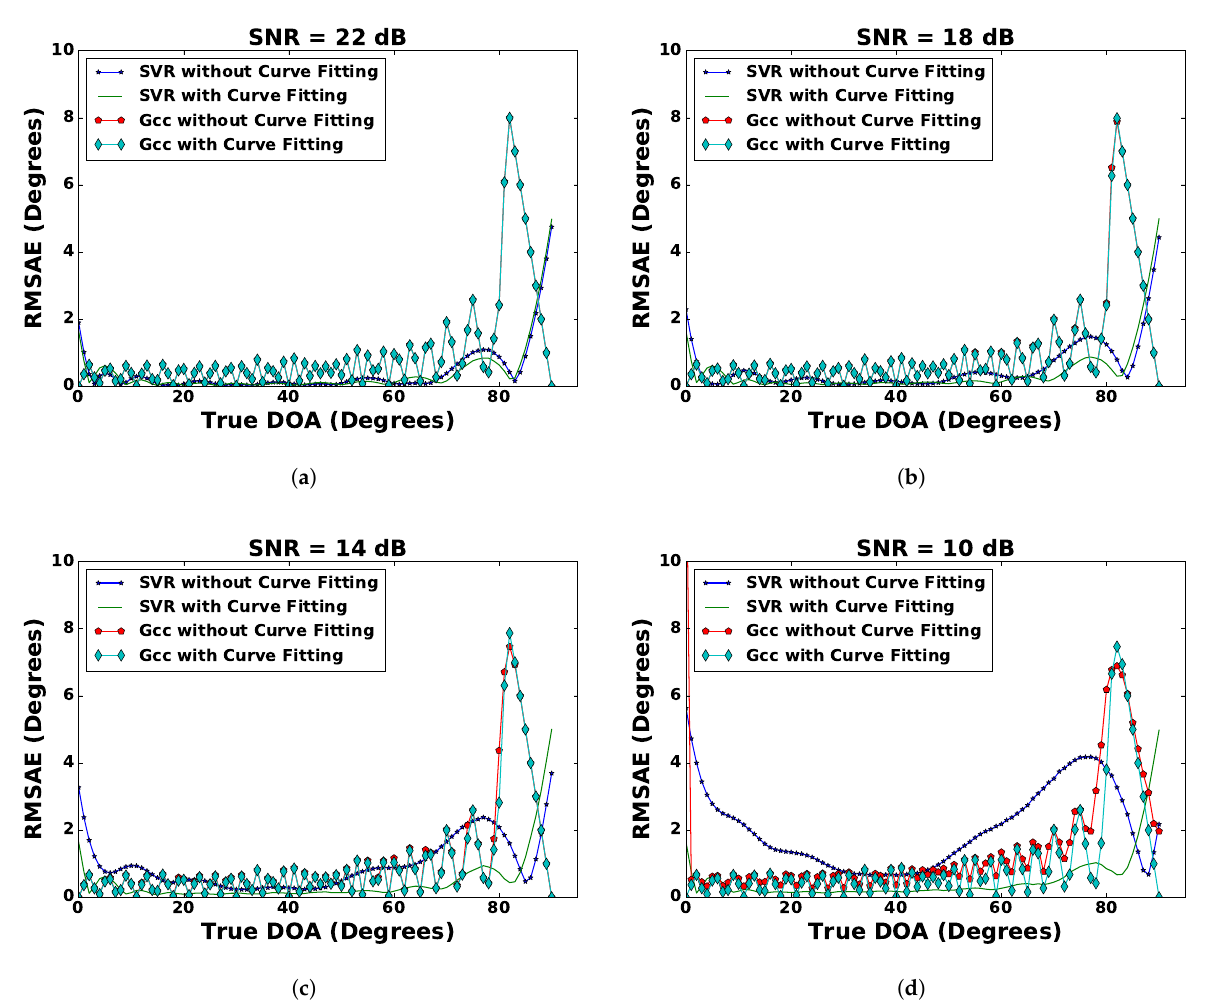
Figure 5. Comparison of SVR and the GCC with and without curve fitting for ( a ) SNR = 22 dB, ( b ) SNR = 18 dB, ( c ) SNR = 14 dB, and ( d ) SNR = 10